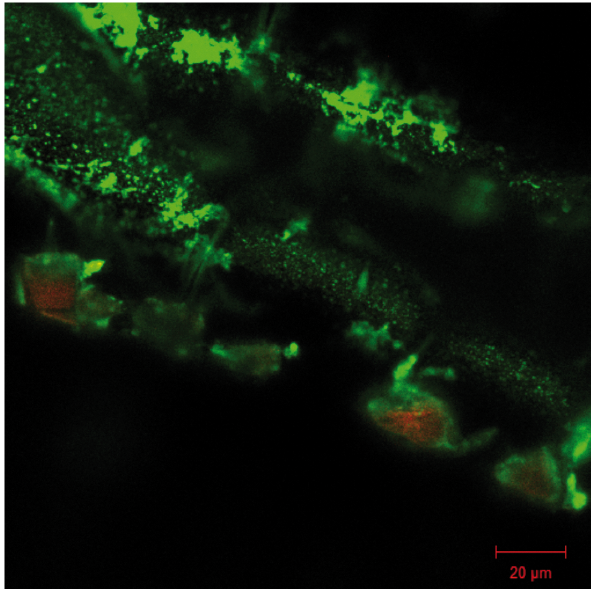
Figure 3. Biofilm assessment with confocal laser scanning microscopy. LIVE/DEAD stain of biofilm formation by day 15 post surgery on tibia implant. Due to the distinct shape of the implant, z- stack construction was not viable, but the confocal image demonstrate multiple areas of multicellular clusters of coccoid cells, that are viable. doi:10.1371/journal.pone.0103688.g003 animals in each group was scheduled to day 4, 6, 8, 11 and 15 after surgery. Five animals from each group were kept in separate cages and were utilized for bioluminescence imaging (BLI). The animals were anaesthetized with isoflourane, intracardial aspira- tion yielded blood for culture and the mice were then euthanized by cervical dislocation. The tibias were removed postmortem, and were immediately frozen at 2 80 u C. Blood was drawn antemortem by intracardial aspiration, with a total volume of 0.3 ml drawn from each animal. Blood cultures were done on 5% blood agar plates (SSI Diagnostic, Hillerød, Denmark) and incubated for 24 hours in 37 u C. Three mice, with sterile pins implanted, served as negative controls and were euthanized on day 15 by cervical